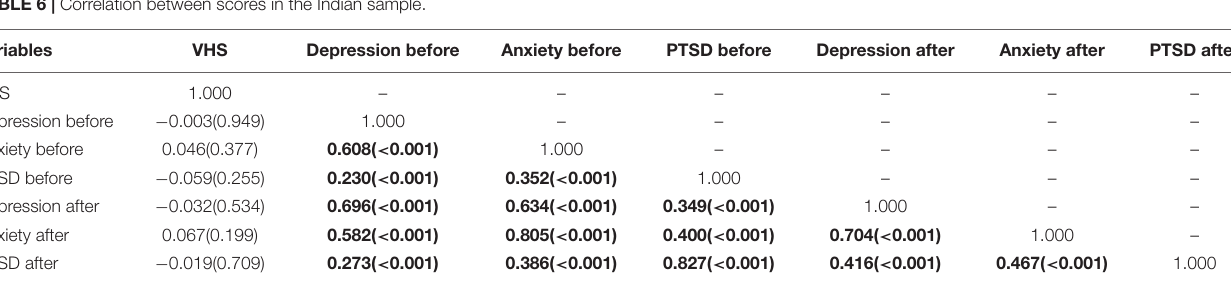
TABLE 6 | Correlation between scores in the Indian